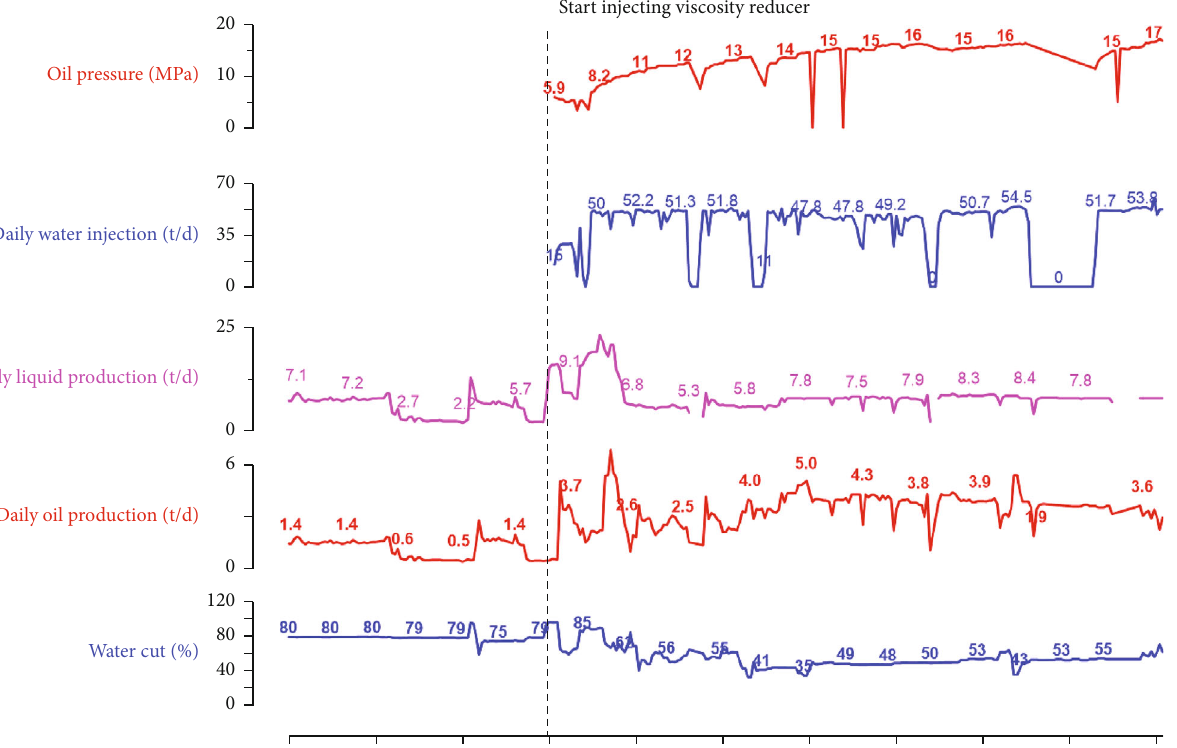
Figure 11: Production curves in the W152-X6 pilot